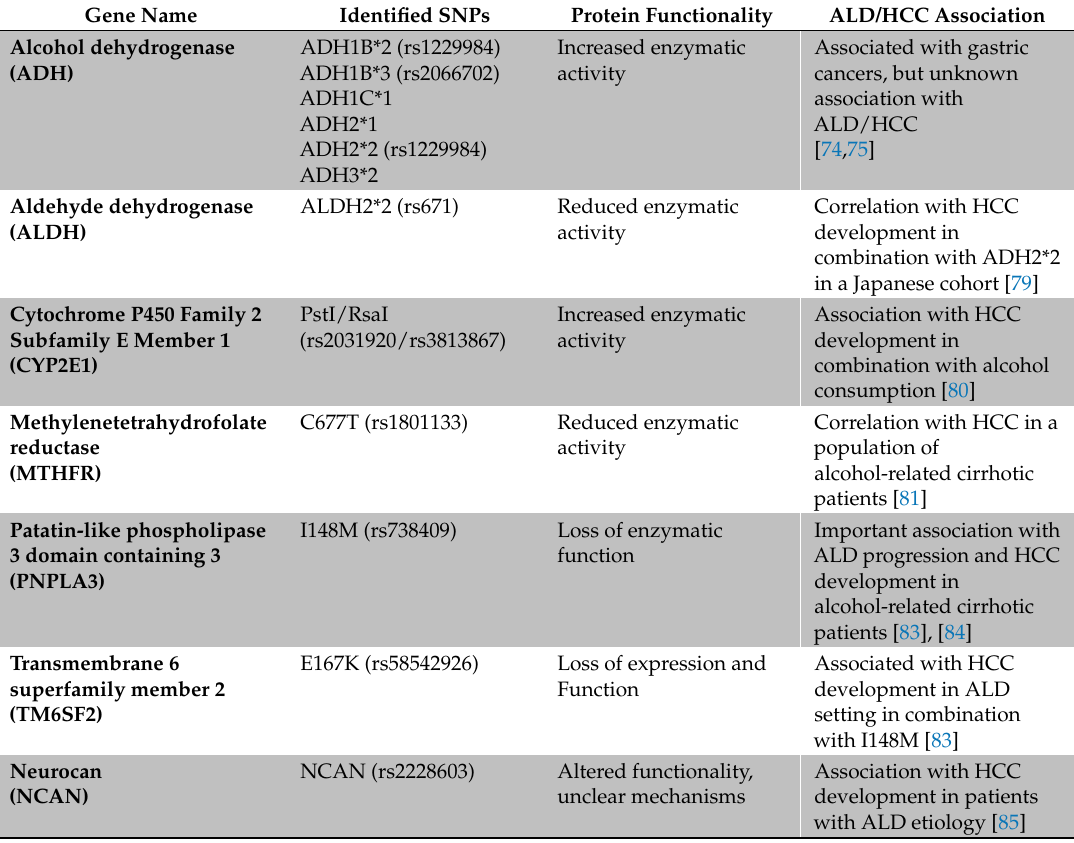
Table 1. Summary of the most frequent single nucleotide polymorphisms associated with ALD progression and HCC